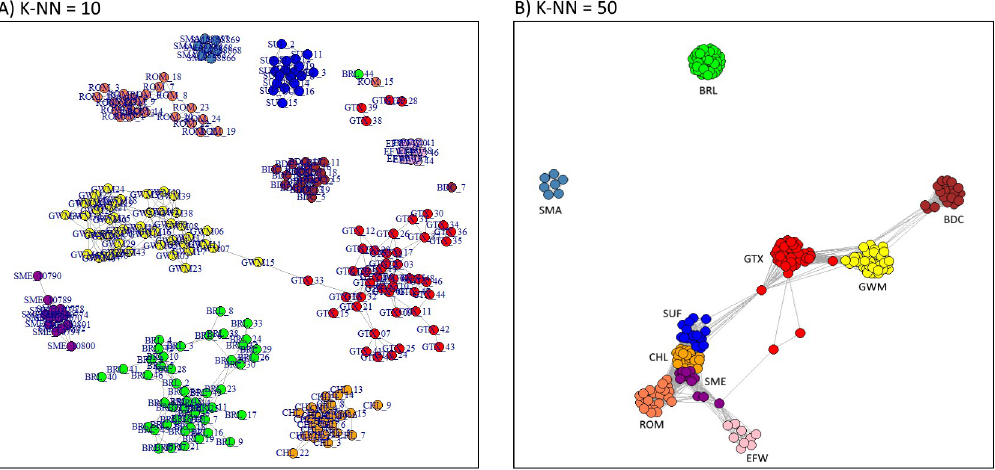
Fig 6. Fine- and large-scale network visualisation of relatedness in the 10 sheep